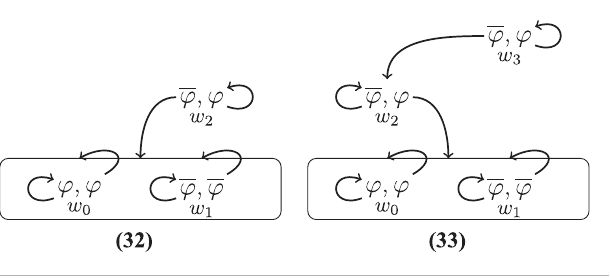
TABLE 13 | Epistemic graphs for examples of assertions with false beliefs and